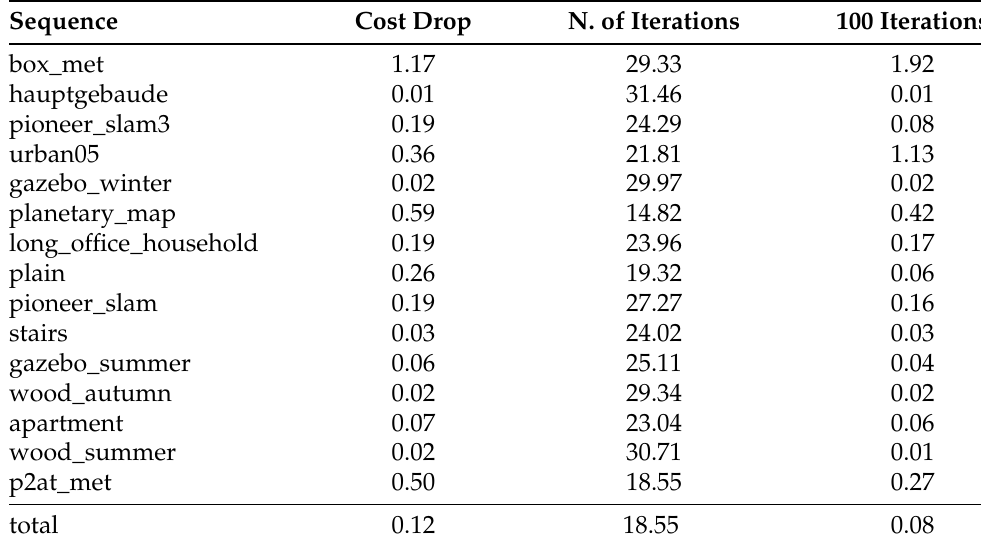
Table 3. The median of the results of Probabilistic Point Clouds Registration (PPCR) on a compre- hensive benchmark [6] with two different termination criterion: 100 iterations and the cost drop. For the cost drop we list also the number of iterations used to reach the solution (under the column N. of iterations ).